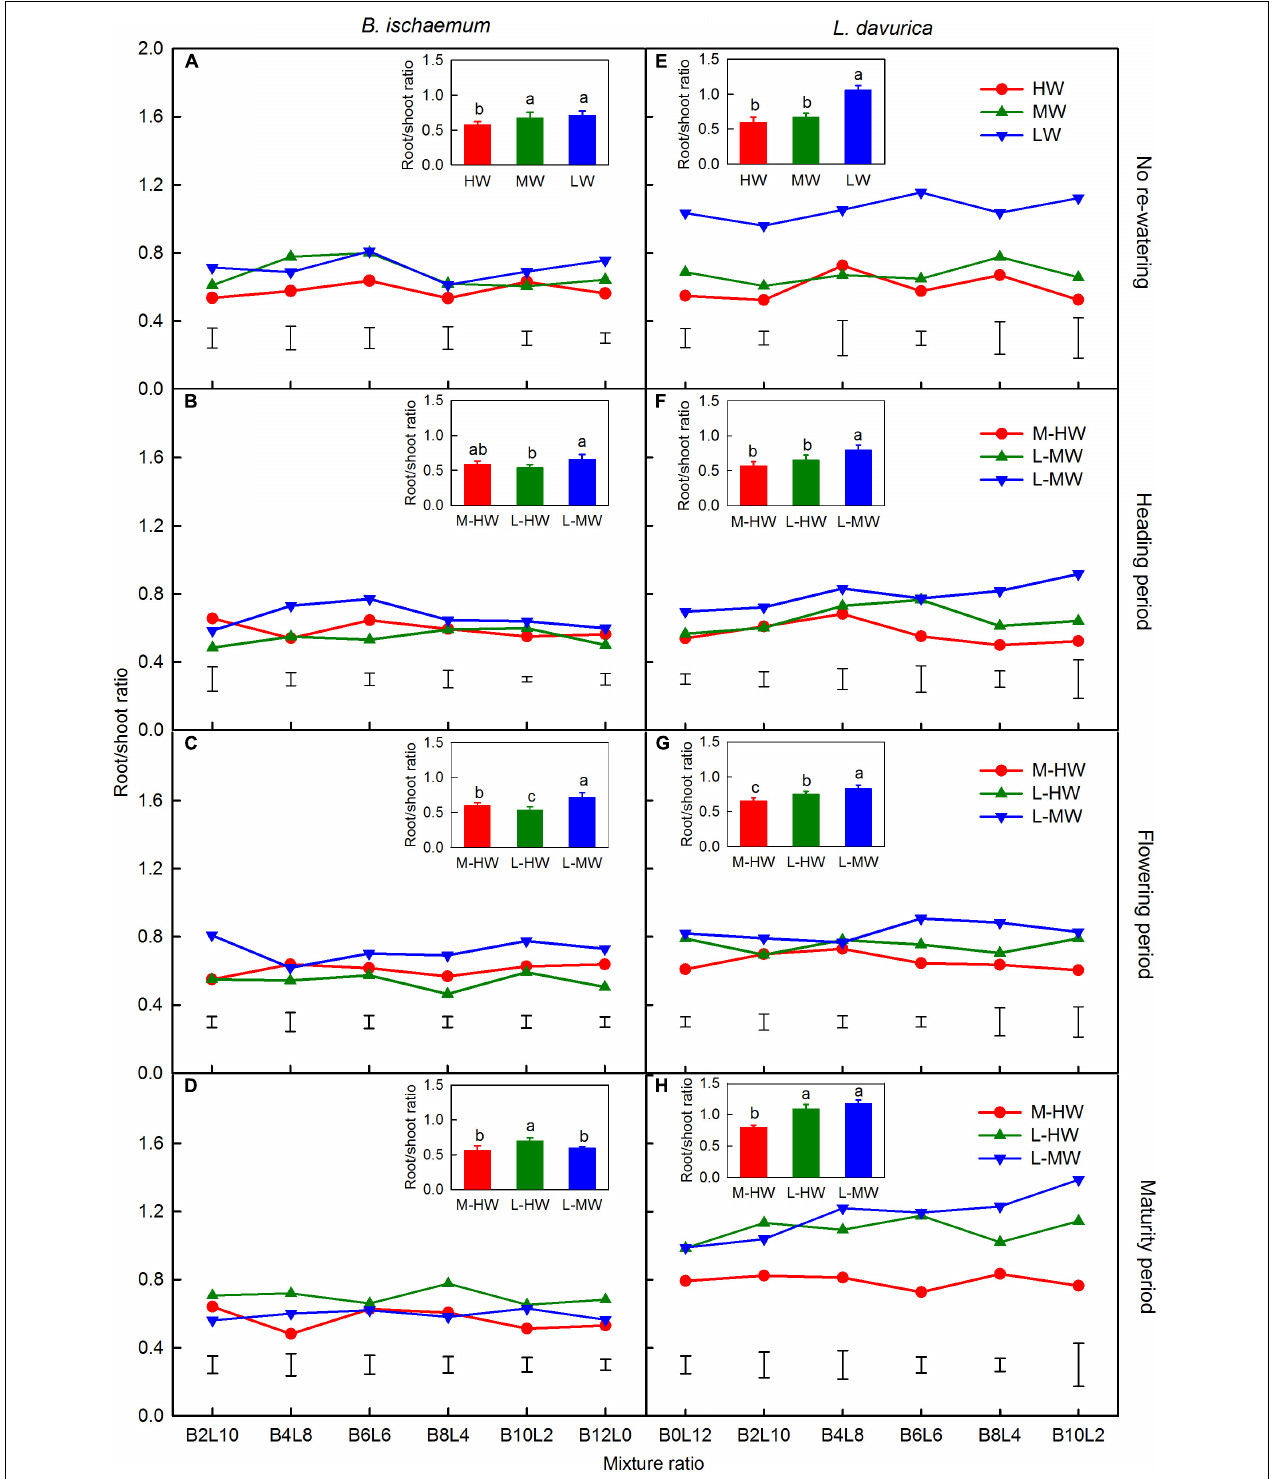
FIGURE 3 | (A–H) The root/shoot ratio (RSR) of B. ischaemum (B) and L. davurica (L) under the soil watering treatments during different growth periods within the replacement series. B i L j ( i, j = 0, 2, 4, 6, 8, 10, 12; i + j = 12) in abscissa indicates the plant numbers of B. ischaemum to L. davurica in the mixtures; Vertical bars represent LSD 0.05 values. The values in the small histogram are the mean across all mixture ratios, and the columns and bars indicate the mean ± SE, the letters are used for the comparisons between different water treatments by LSD test ( P < 0.05). Refer to Figure 1 for the codes of the water treatments.